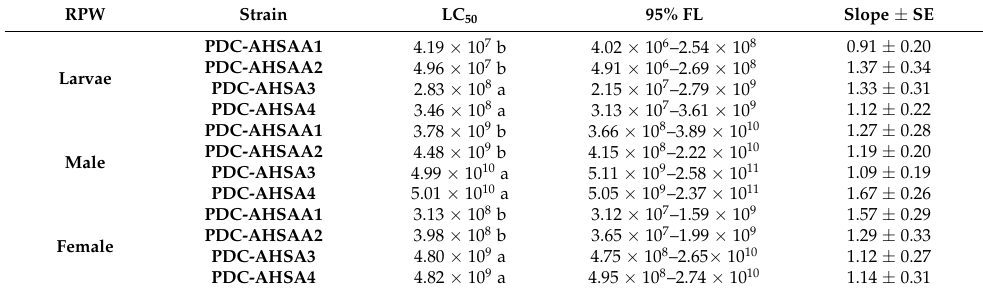
Figure 4. Phylogenetic dendrogram showing the position of Bacillus cereus strain PDC-AHSA4 among phylogenetic neighbors. Table 1. Insecticidal activity of Bacillus thuringiensis and B. cereus isolates against RPW larvae and adults after three weeks of